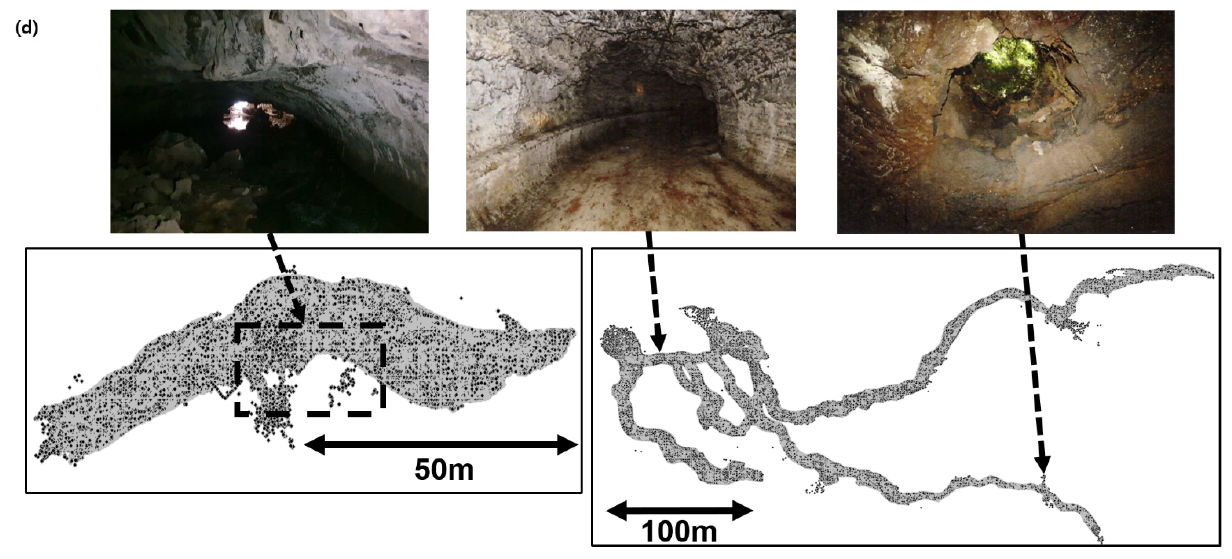
Figure 1. Geological context and lava caves of Jeju Island. ( a ) Lava tubes in detailed geological units associated with cinder cones and lava flows. ( b ) Lava tube distribution, bedrock geology, and road networks. ( c ) The topography of Jeju Island is shown and locations of major study sites are labeled. Hereafter, a map projection is WGS 84 geographic coordinate system unless otherwise noted. ( d ) TLS point distributions demonstrating internal structures and on-site photos collected in Geamcheon, Chogiwak caves. Geological units and background geology, together with cone volcanoes distribution, are based on [38]. The lava tube distribution is taken from [16]. Photos in Chogiwak cave were taken from the Korean Cultural Heritage Administration.